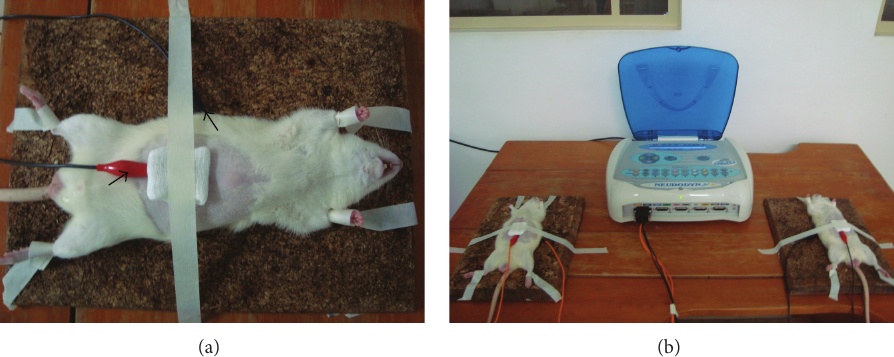
Figure 1: Illustration of the preparation of animals for treatment by means of iontophoresis: (a) detail of the animal with electrodes fixed in the anterior region of the abdomen and on the dorsal region (arrows) for treatment commencement; (b) animals during the electrotherapeutic